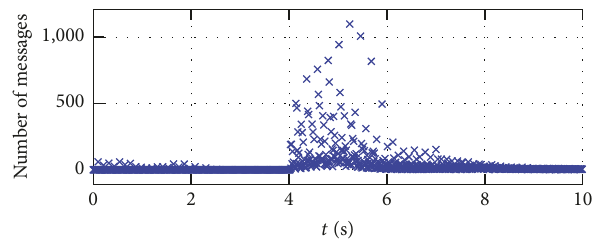
Figure 12: Number of messages sent between agents. Table 3: Execution time results for different grid sizes.